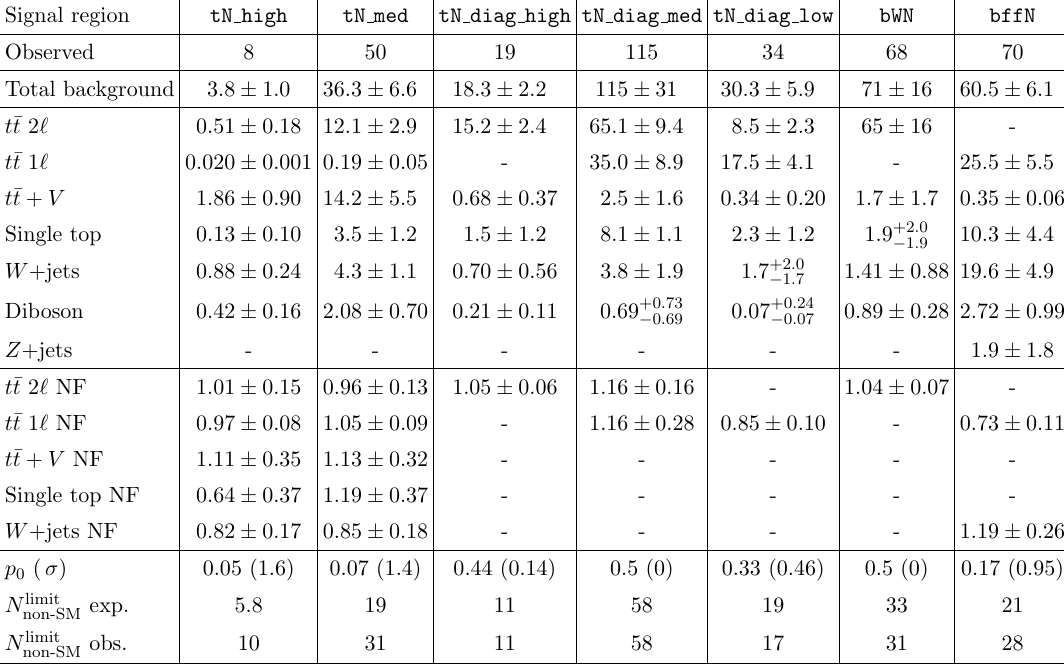
Table 23 . The numbers of observed events in the pure bino LSP SRs together with the expected numbers of background events and their uncertainties as predicted by the background-only (cid:12)ts, the normalisation factors (NF) for the background predictions obtained in the (cid:12)t, the probabilities (represented by p 0 values, and capped at 0.5) that the observed numbers of events are compatible with the background-only hypothesis, and the expected ( N limit exp.) and observed ( N limit obs.) non-SM non-SM 95% CL upper limits on the number of beyond-SM events. Some of the SRs where t (cid:22) t background events are predominantly semileptonic or dileptonic have only one NF which is also applied to the subdominant t (cid:22) t contribution. Backgrounds with no associated NF are normalised with the theoretical